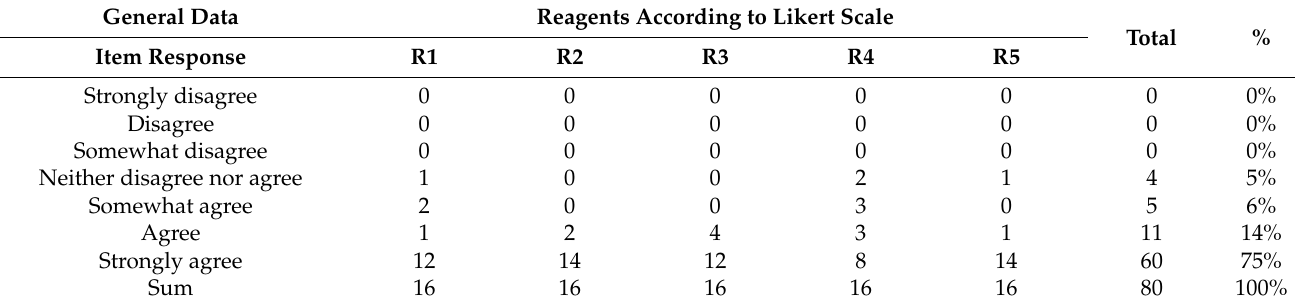
Table 7. Frequency analysis of the reagents of the evaluation of the perception of use and satisfaction. General Data